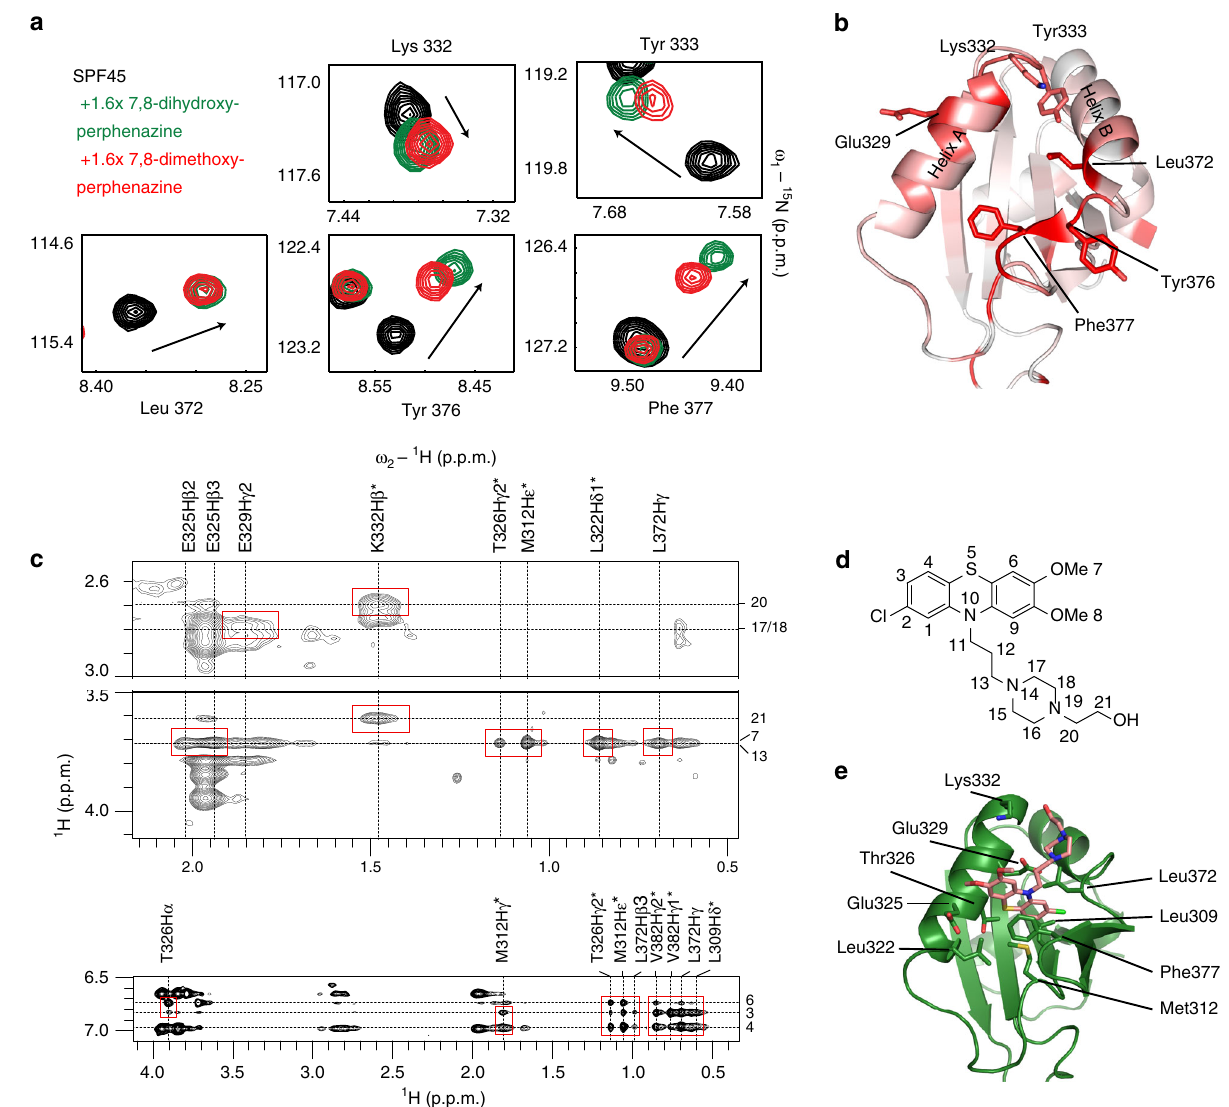
Fig. 3 Binding site mapping and structural model of the phenothiazine-SPF45 UHM interaction. a 1 H- 15 N HSQC experiments of 80 μ M 15 N-labeled SPF45 UHM domain free (black) and in the presence of 1.6-fold molar excess of 7,8-dihydroxyperphenazine (green) or 7,8-dimethoxyperphenazine (red). b Residues which show signi fi cant amide CSPs upon titration of 7,8-dimethoxyperphenazine are highlighted in red on the structure of the SPF45 UHM domain. c 2D ω 1 - fi ltered NOEs between the SPF45 UHM domain and 7,8-dimethoxyperphenazine are shown. Red boxes indicate NOEs that were assigned and used in docking calculations. Chemical shift assignments of SPF45 protons and of the compound are shown on top and at the right-hand side of the spectrum, respectively. d Chemical structure of 7,8-dimethoxyperphenazine with atom numbering. e The lowest energy structure from the HADDOCK cluster is shown with the binding site residues. 7,8-dimethoxyperphenazine is colored in